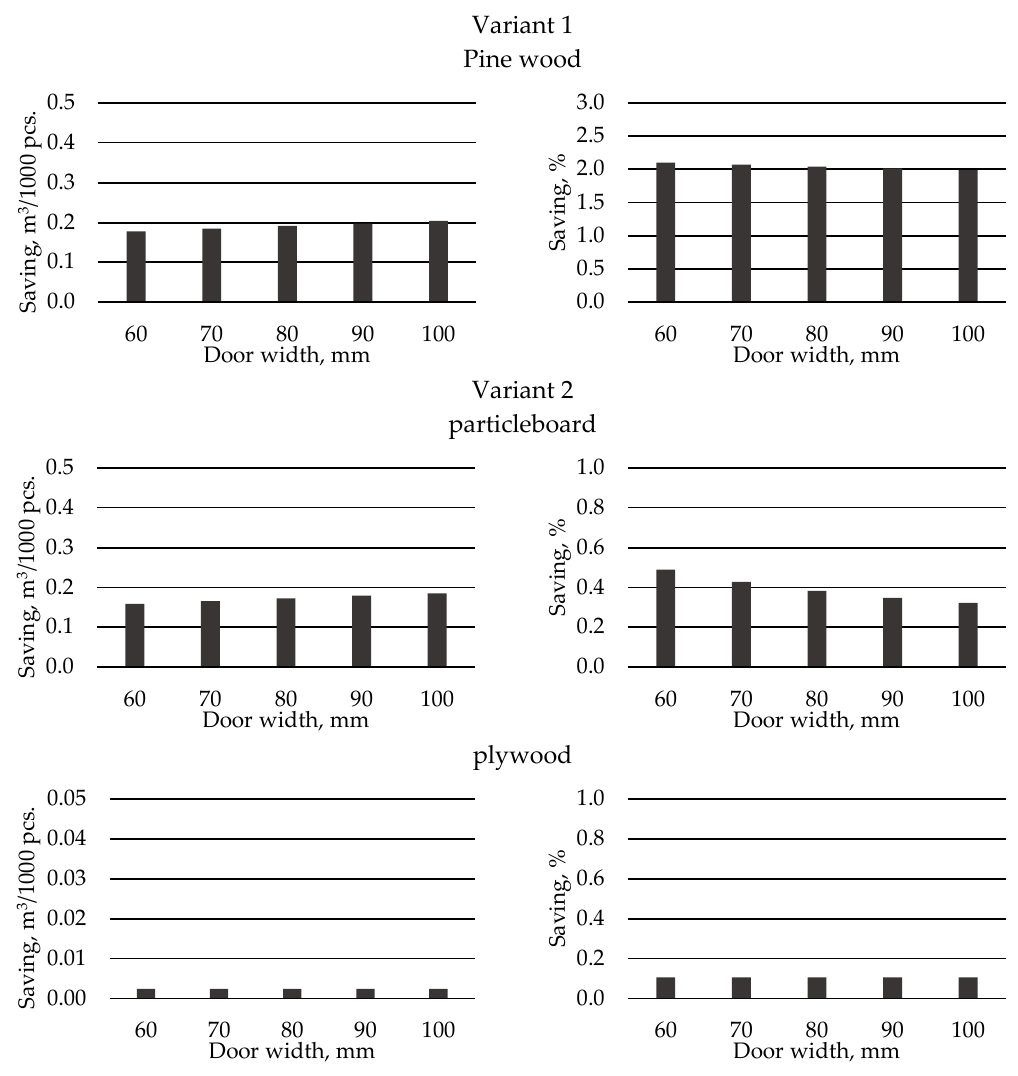
Figure 7. Material savings obtained by reducing the machining allowance in construction 1.